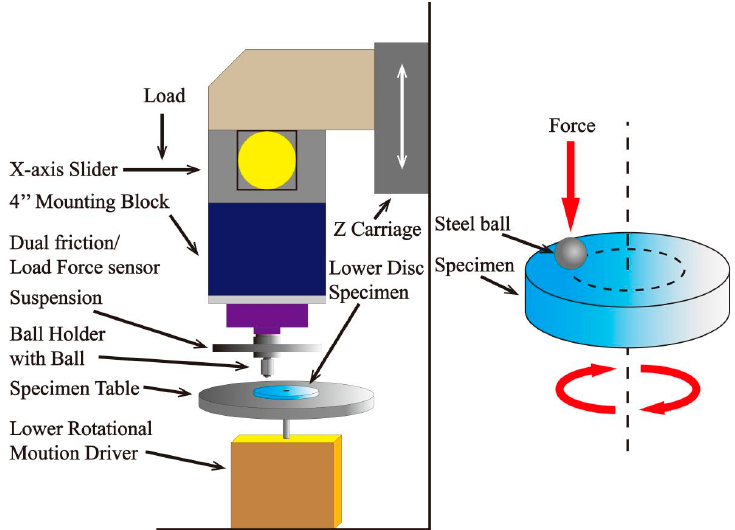
Figure 10. Schematic illustration of UMT3 tribometer for the ball-on-disc sliding test [61]. Reproduced